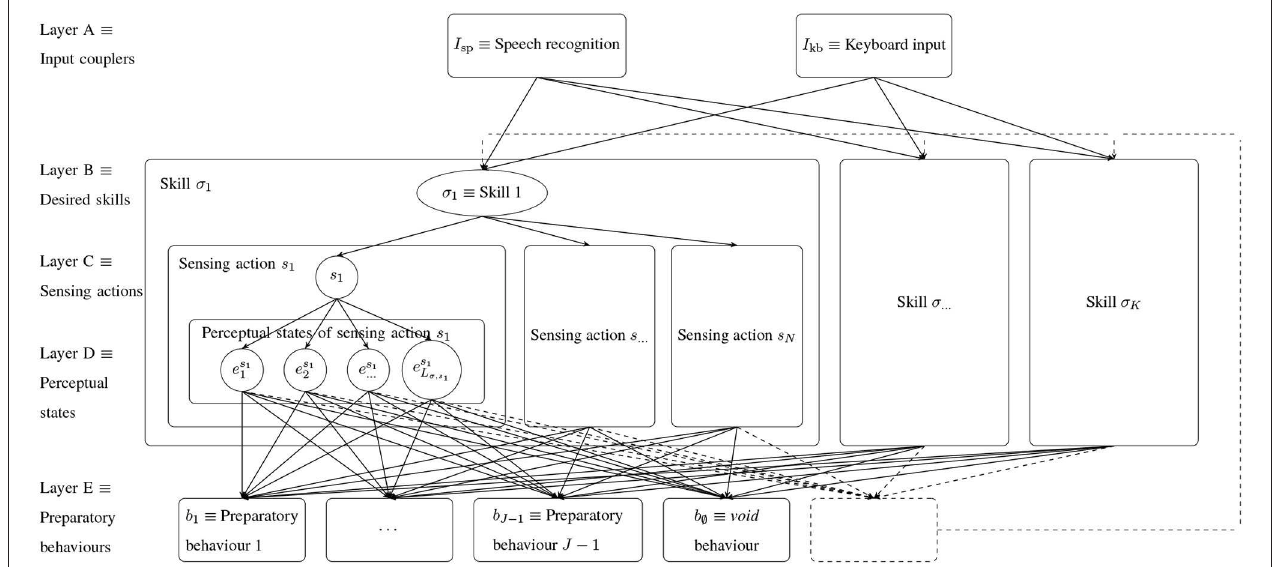
FIGURE 2 | ECM for autonomous robotic playing. For execution a random walk is performed from layer A to layer E. The transition from layer C to layer D is performed by executing the corresponding sensing behavior s , measuring the haptic data and using a time series classifier. All other transitions follow Equation (6). The preparatory behavior b ∅ ≡ ( void behavior) is always in the set of preparatory behaviors. The dashed box and lines refer to skills used as preparatory behaviors in order to build skill hierarchies. After preparation, the basic behavior b σ corresponding to the desired skill σ is executed. The active learning approach presented in this paper enables the robot to perform transitions between clips on layer D. The behavior composition extension helps the robot to add new preparatory behavior compositions in layer E. The ECM shown in this figure is independent of the environment model and will only be influenced (e.g., by adding new clips) in case the environment model becomes more